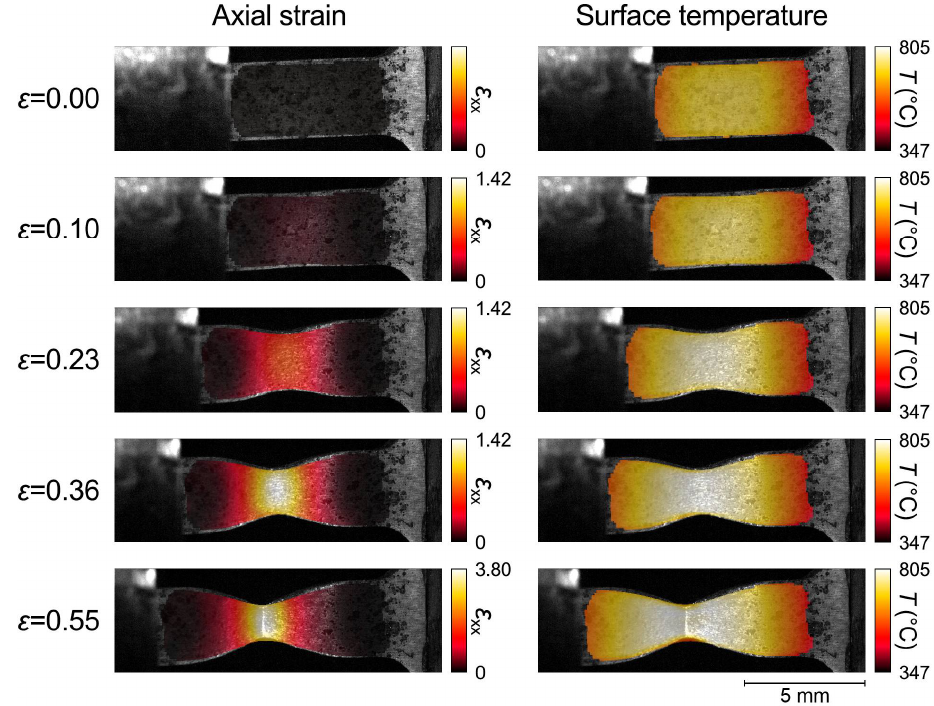
Figure 17. Full-field axial strains and surface temperatures at different global engineering strains in a commercially pure titanium specimen loaded in tension at an average initial temperature of 700 °C and a strain rate of approximately 1600 s −1 .